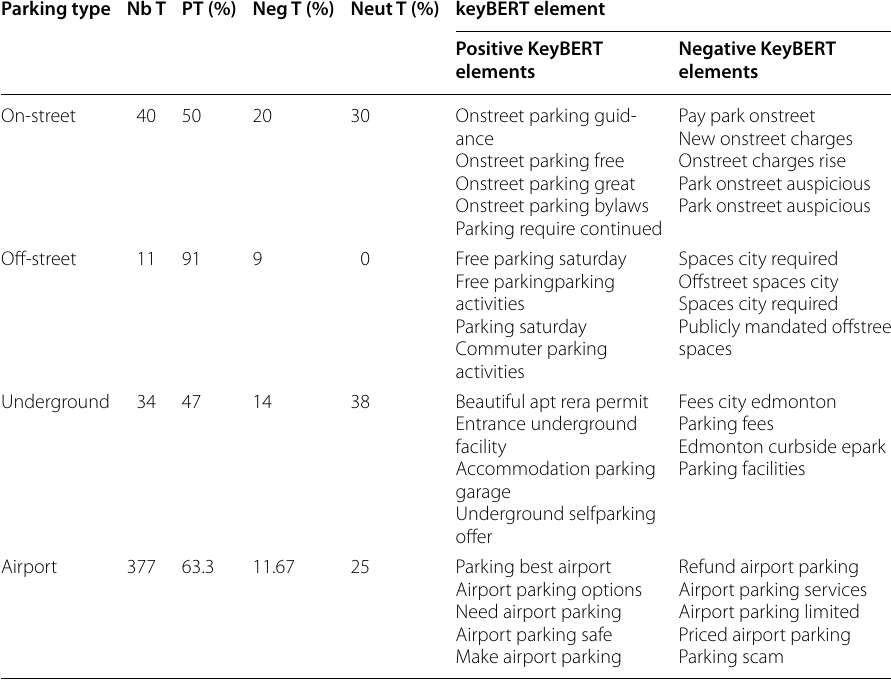
Table 2 Parking types and corresponding